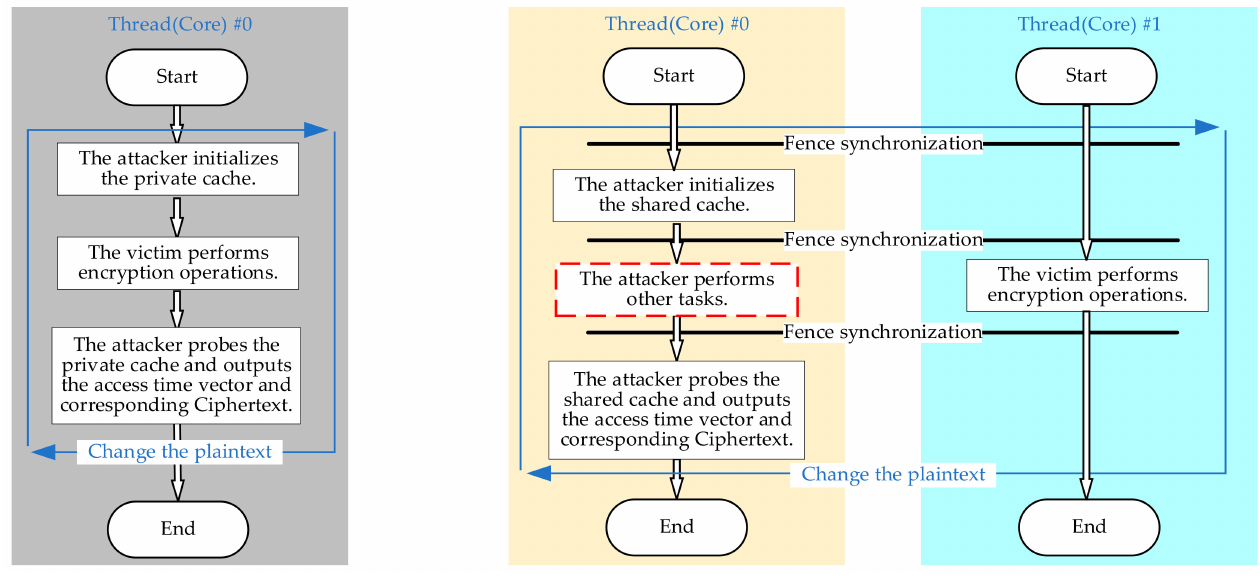
Figure 2. Local attack model ( left ) and cross-core attack model ( right